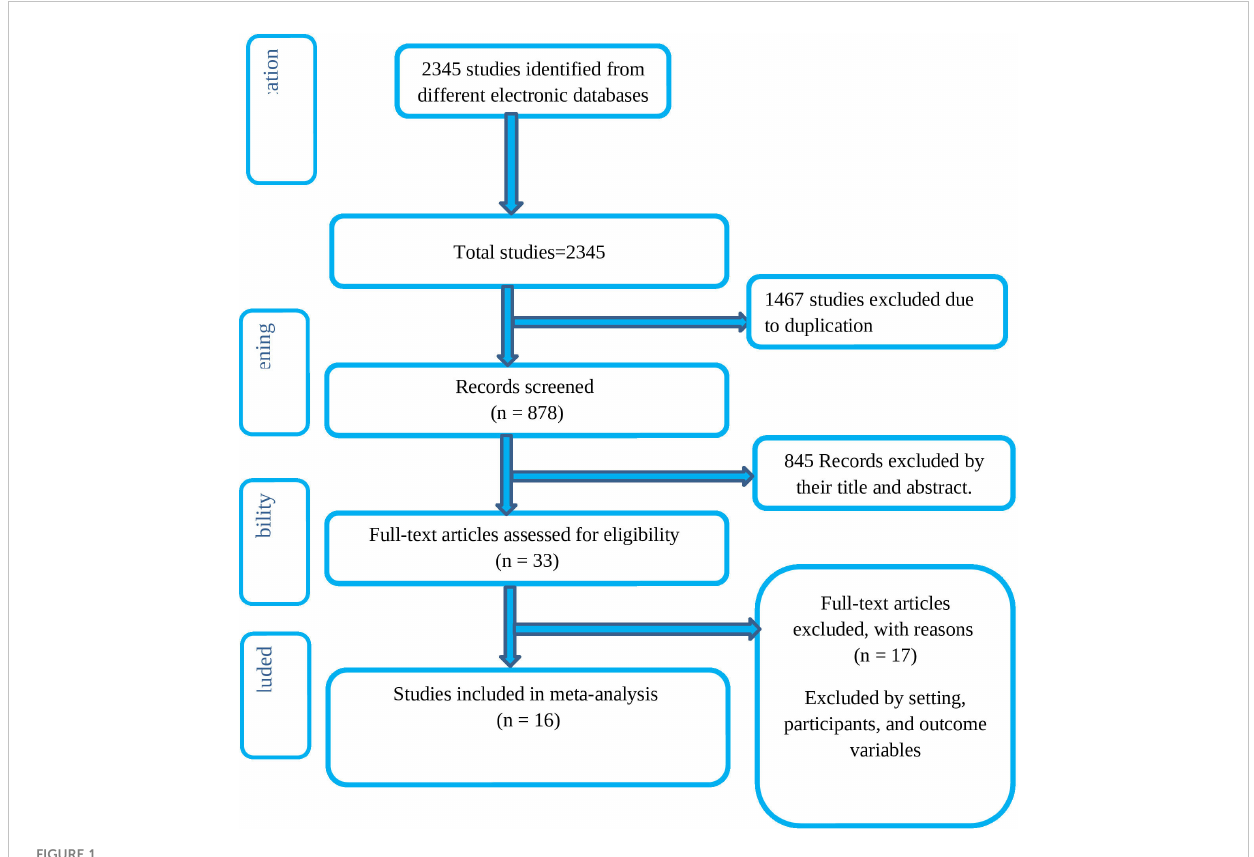
FIGURE 1 Flow diagram of the studies included in the